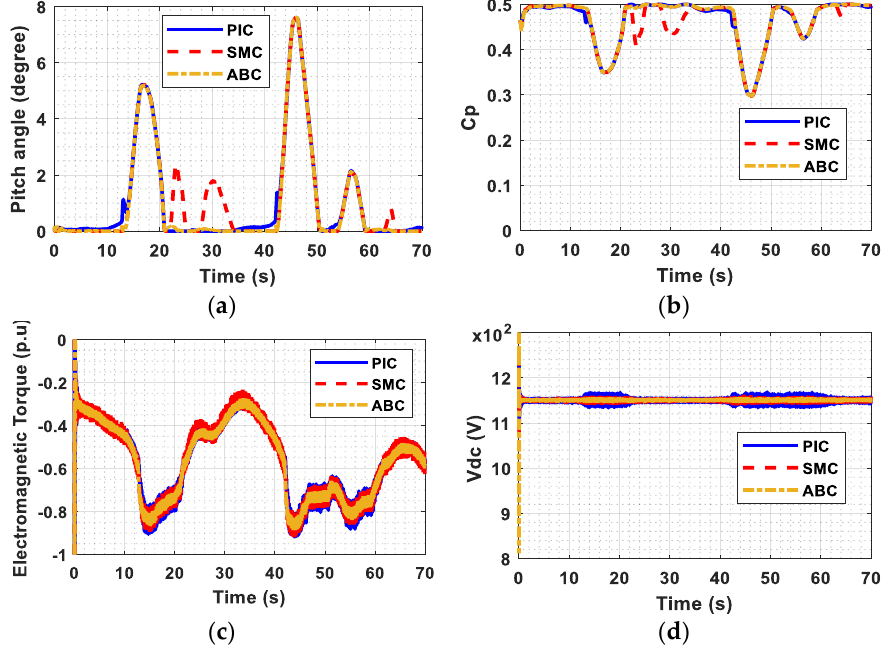
Figure 10. Controllers’ response in real time; ( a ) Pitch angle, ( b ) Power coefficient, ( c ) T em , and ( d ) DC-link voltage. Table 1. Tracking error